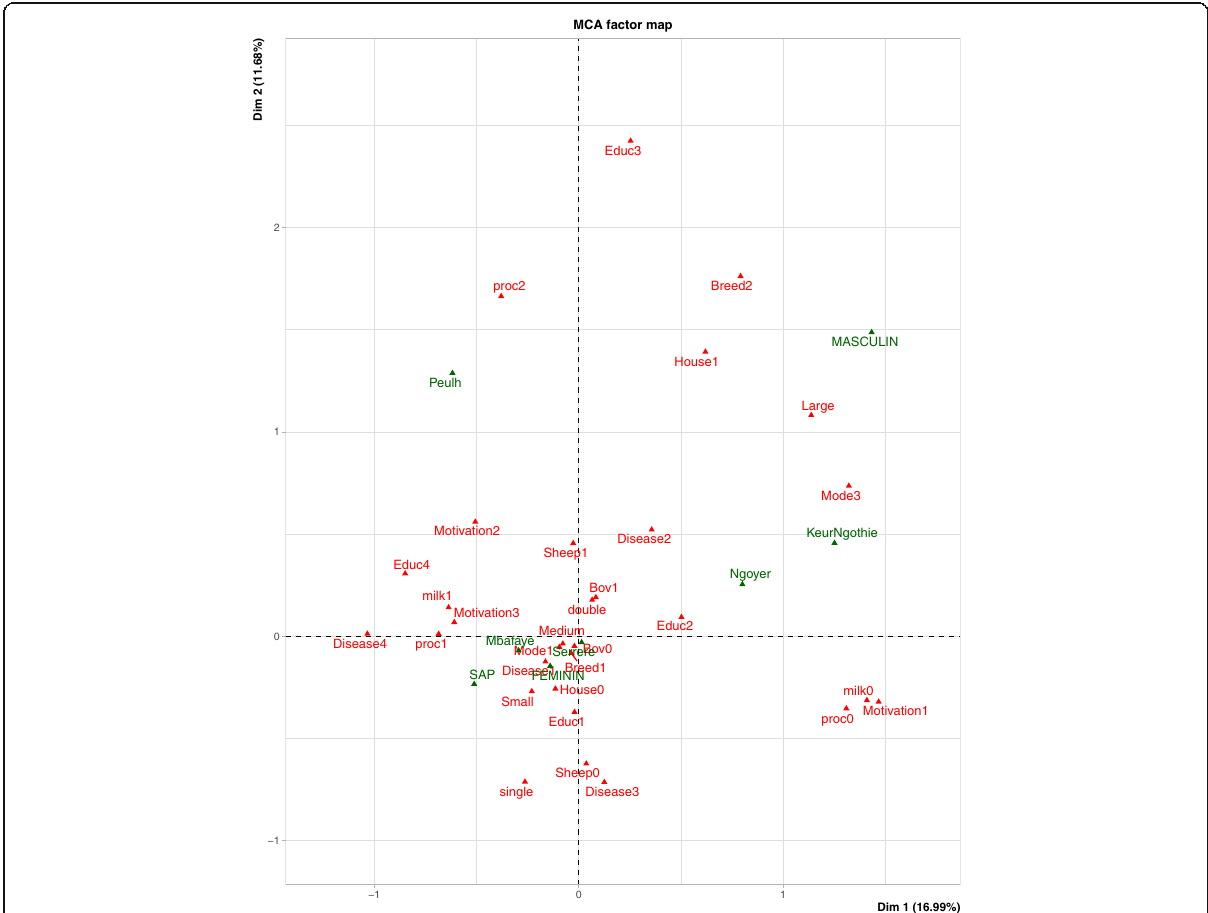
Fig. 2 Modalities associated to axes 1 and 2 of MCA applied to the typology of goat production systems in the Fatick region, Senegal (see Table 1 for the signification of